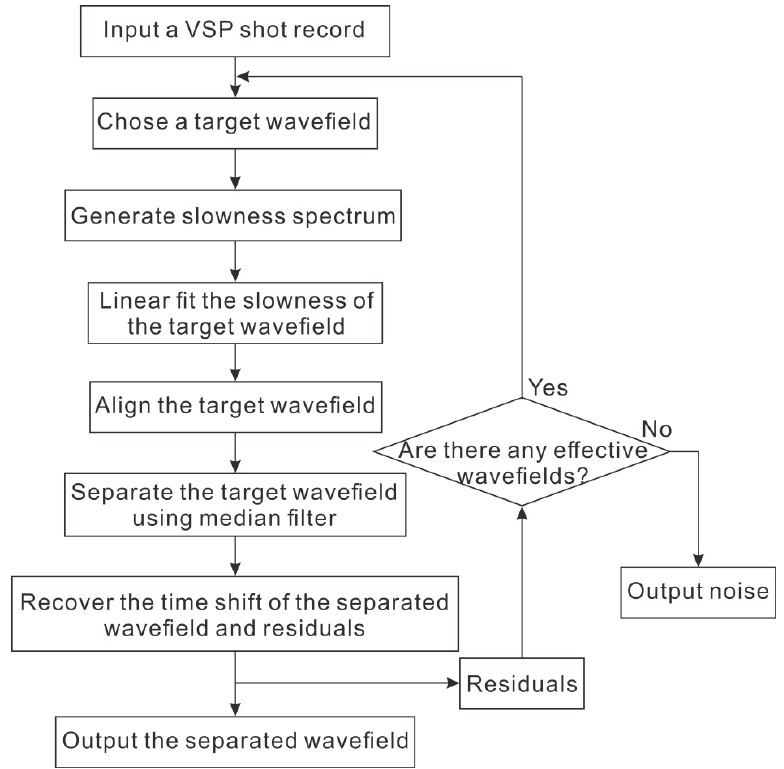
Figure 3. Flowchart of separation for the vertical seismic profile (VSP) wavefield.